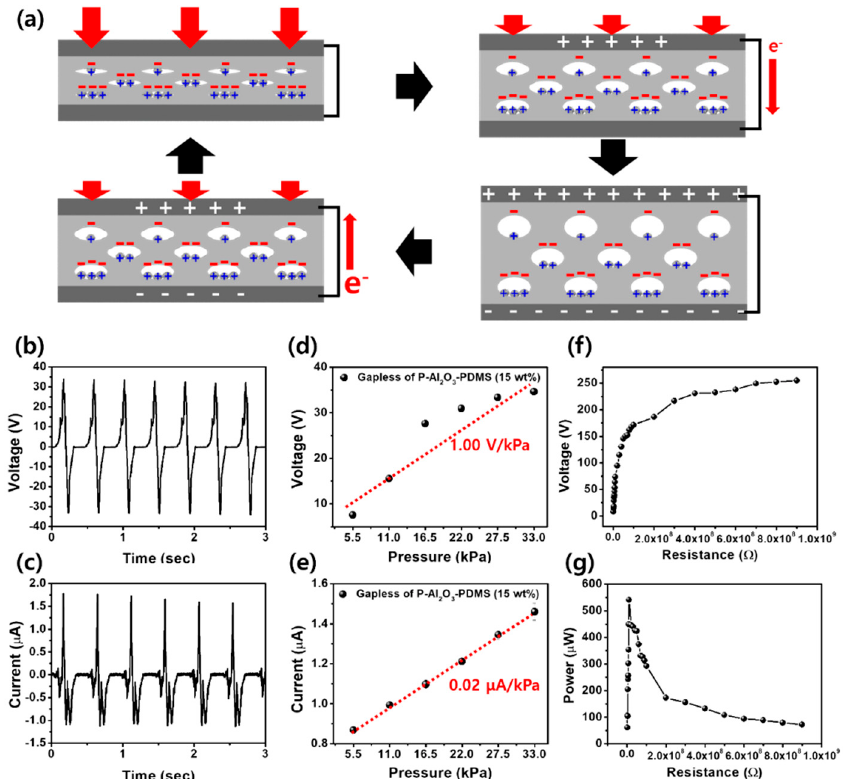
Figure 4. Gapless TENG with a mesoporous Al 2 O 3 -PDMS (15 wt%). ( a ) The schematic of the mesoporous Al 2 O 3 -PDMS (15 wt%) gapless system. ( b ) Output voltage and ( c ) current. The